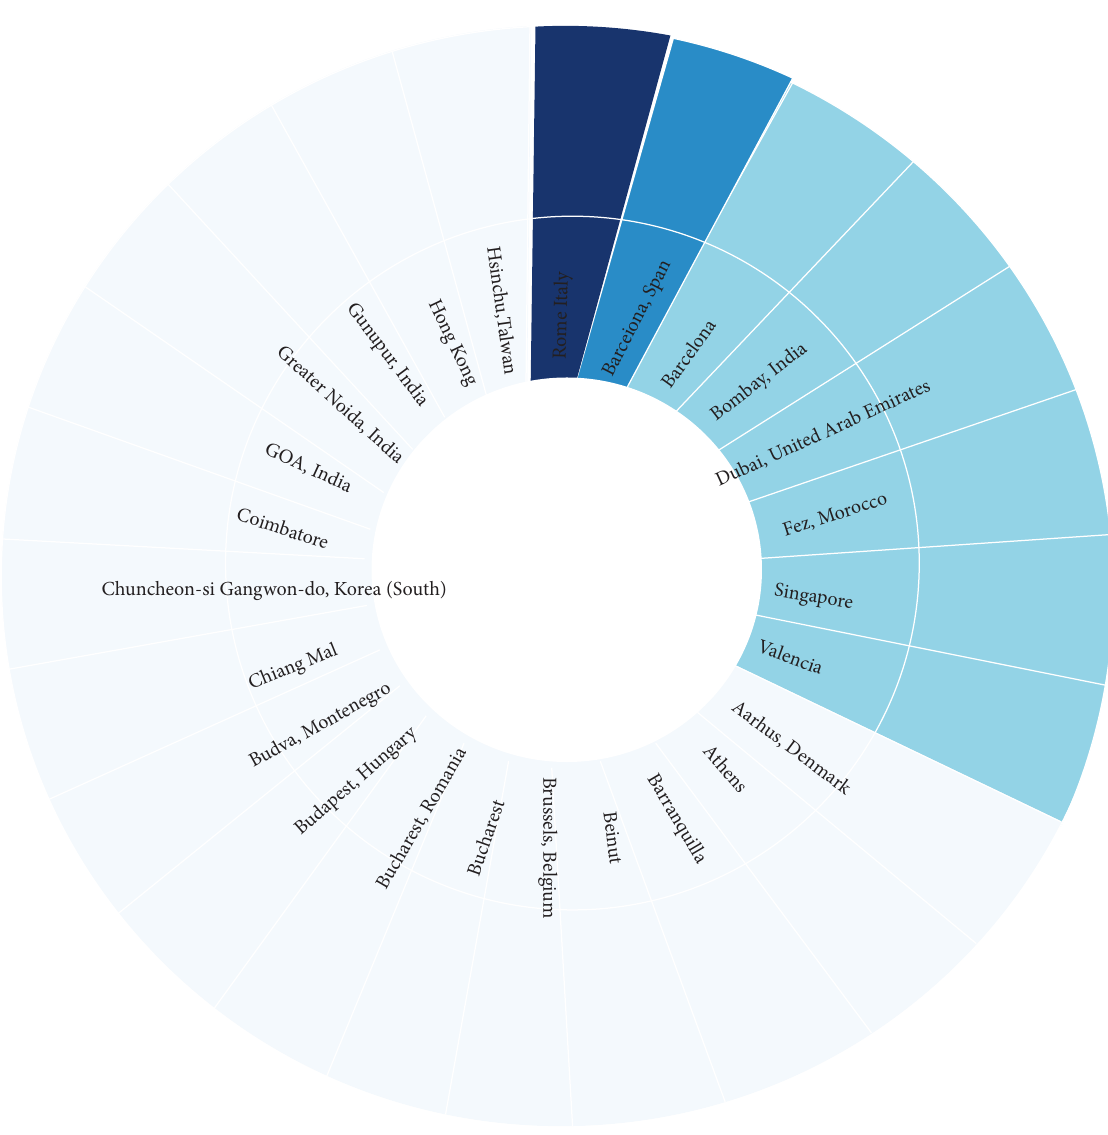
Figure 6: Conference locations and papers.